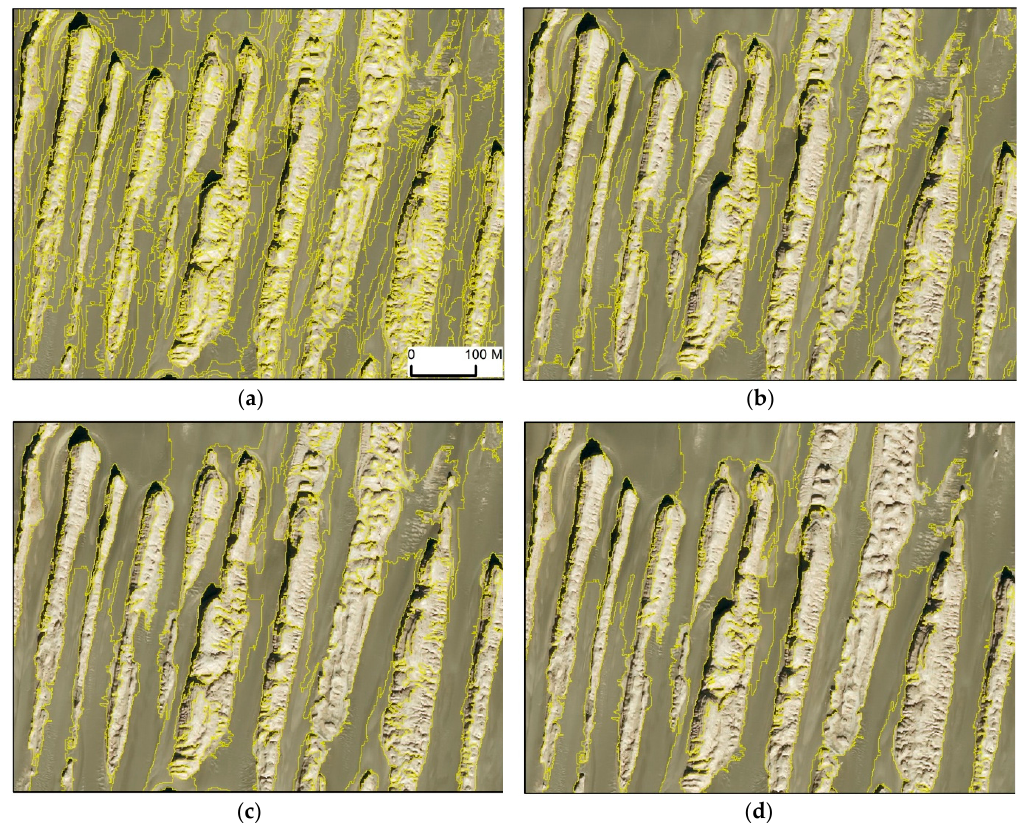
Figure 3. Object levels with different segmentation scales (SC): ( a ) SC=34, ( b ) SC=80, ( c ) SC=138, and ( d ) SC=208.